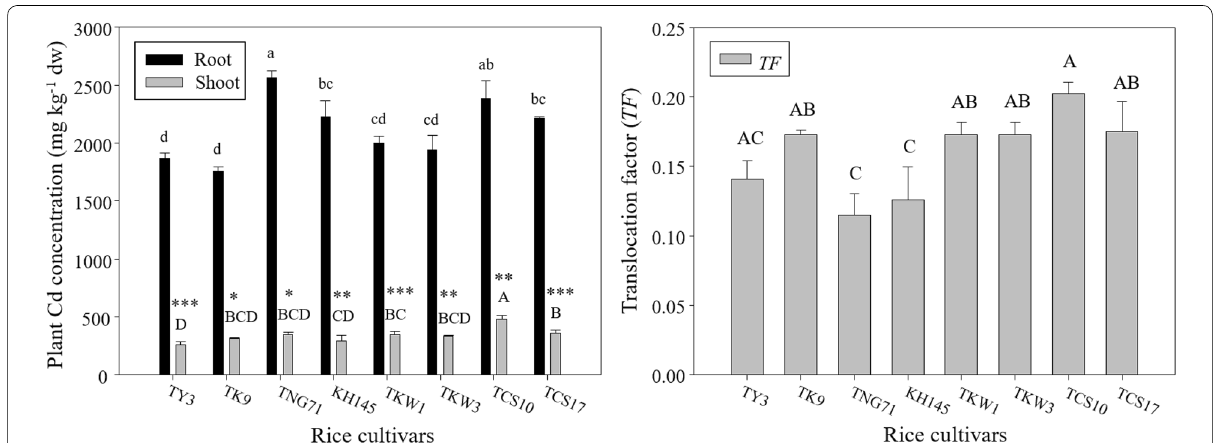
Fig. 1 Concentrations of Cd in root and shoot and translocation factor ( TF ) of the seedlings after a 7‑day exposure of 50 μM Cd (Cd treated) for the rice cultivars (i.e. TY3, TK9, TNG71, KH145, TKW1, TKW3, TCS10, and TCS17). Error bars represent the standard errors of the mean values (replicates n 3). Same lowercase letters above the black bars and same capital letters above the gray bars indicate the mean values are not significantly = different at p < 0.05 among the cultivars according to the last significant difference (LSD). *, **, and *** indicate significant differences at p < 0.05, p < 0.01, and p < 0.001 between root and shoot Cd concentrations by the